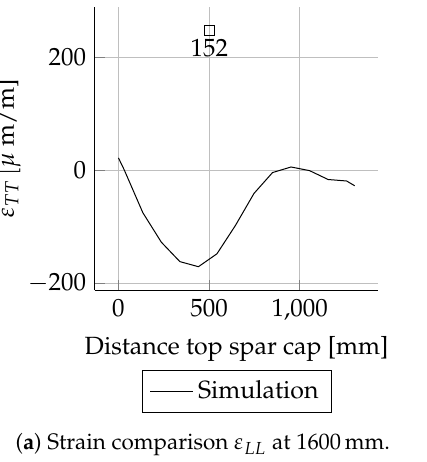
Figure A25. Strain comparison ε LL at radial position R = 17,000 mm for Mxmin load case.